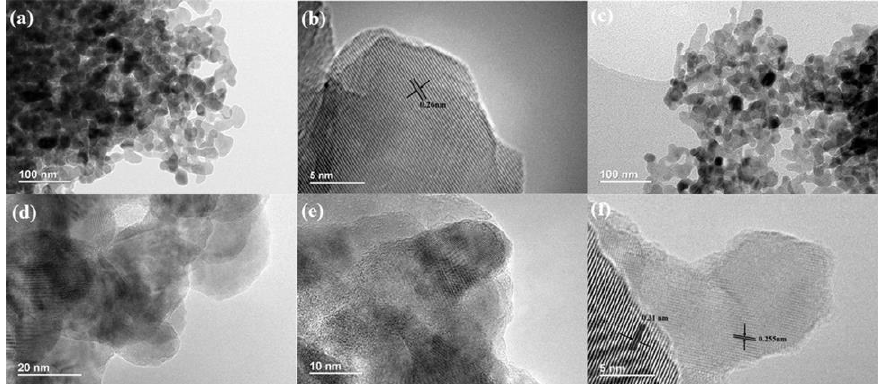
Figure 4. High-resolution transmission electron microscopy (HRTEM) images of ( a , b ) ZnO; and ( c – f ) CN-2/ZnO.